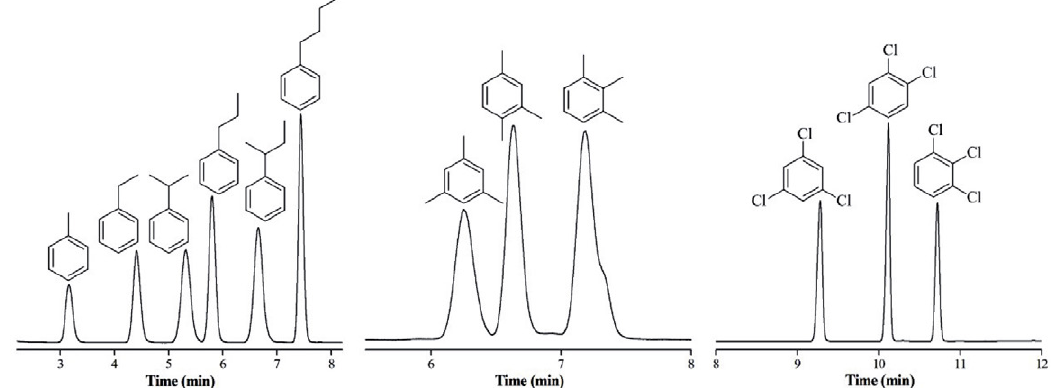
Fig. 3. GC separations of aromatic isomers. Temperature process: 40 °C (keep 1 min) up to 160 °C (keep 5 min) at 10 °C/min and gas flow rate at 0.6 mL/min.